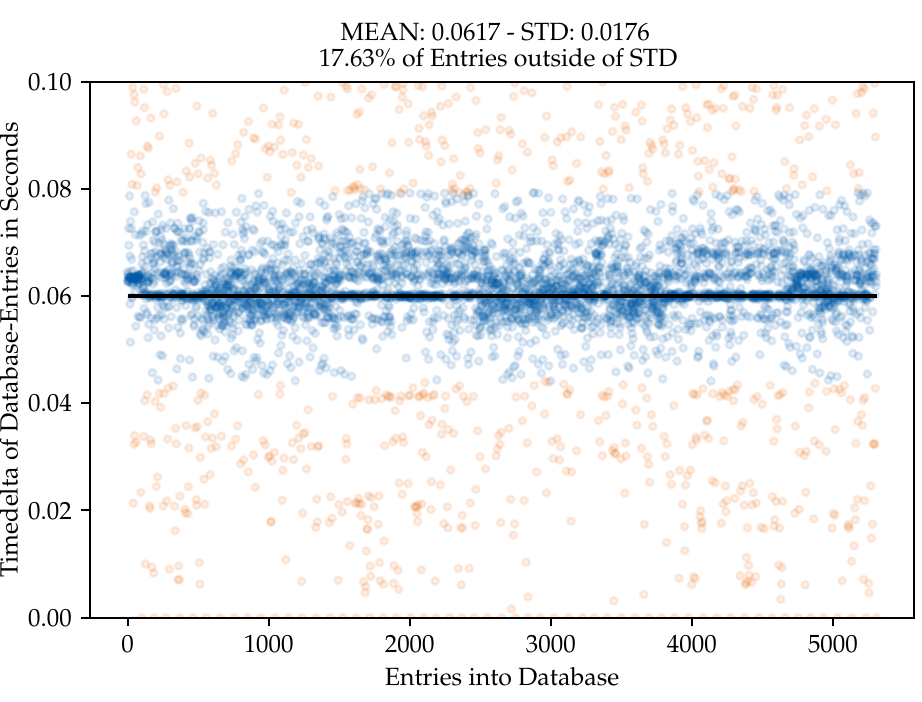
Figure 7. Real-time capability observed through time differences of data entries into